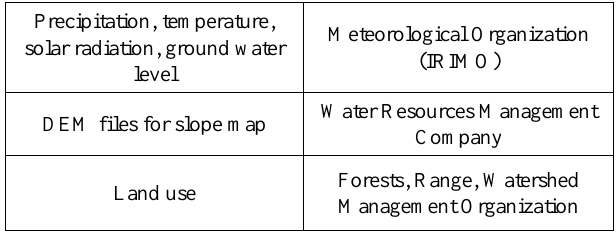
Table 1- Data resources from agencies in